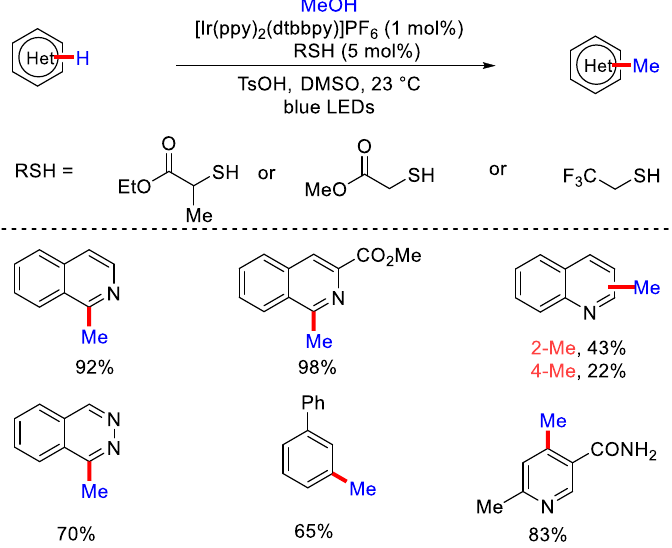
Scheme 3. Photo-redox Ir(III) dual catalyzed methylation of heteroarenes.